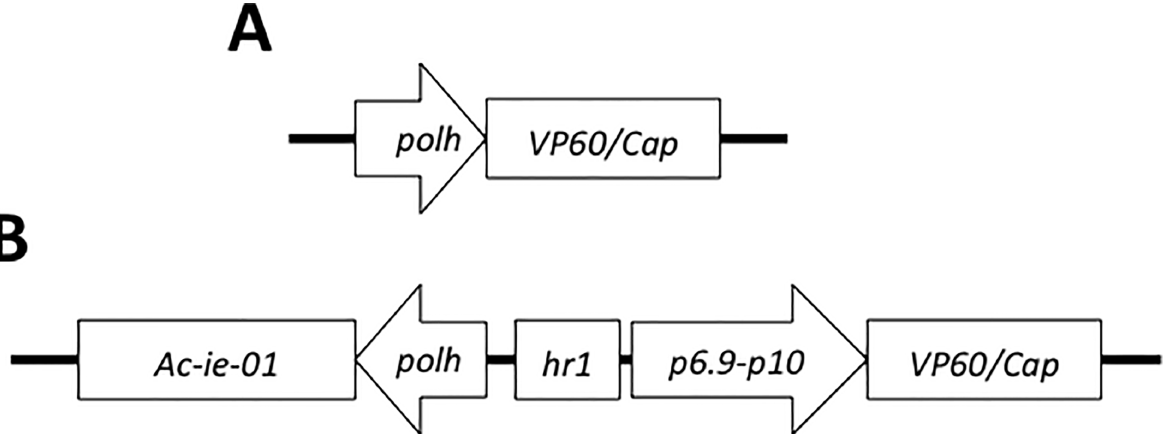
Fig 1. Schematic representation of the two constructs used to generate recombinant baculoviruses expressing the recombinant proteins RHDV-VP60 and PCV2-Cap. A) Expression cassette used to express the recombinant proteins under the control of the polh promoter in a conventional TB (-) baculovirus. B) Expression cassette used to express the recombinant proteins in a TB(+) baculovirus containing all genetic regulatory elements, including the transactivation elements encoded by Ac-ie-01 sequence, the enhancer sequence hr1 , and the combination of promoters p6 . 9 and p10 .